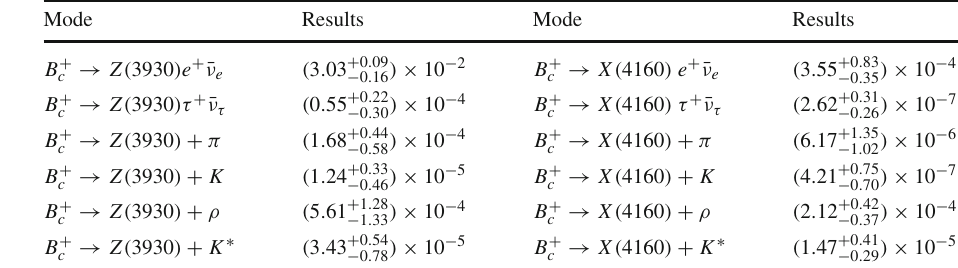
Table 3 The branching ratio(in %) of exclusive semileptonic decay B c to Z ( 3930 ), X ( 4160 ) with the lifetime of = 0 . 453 ps